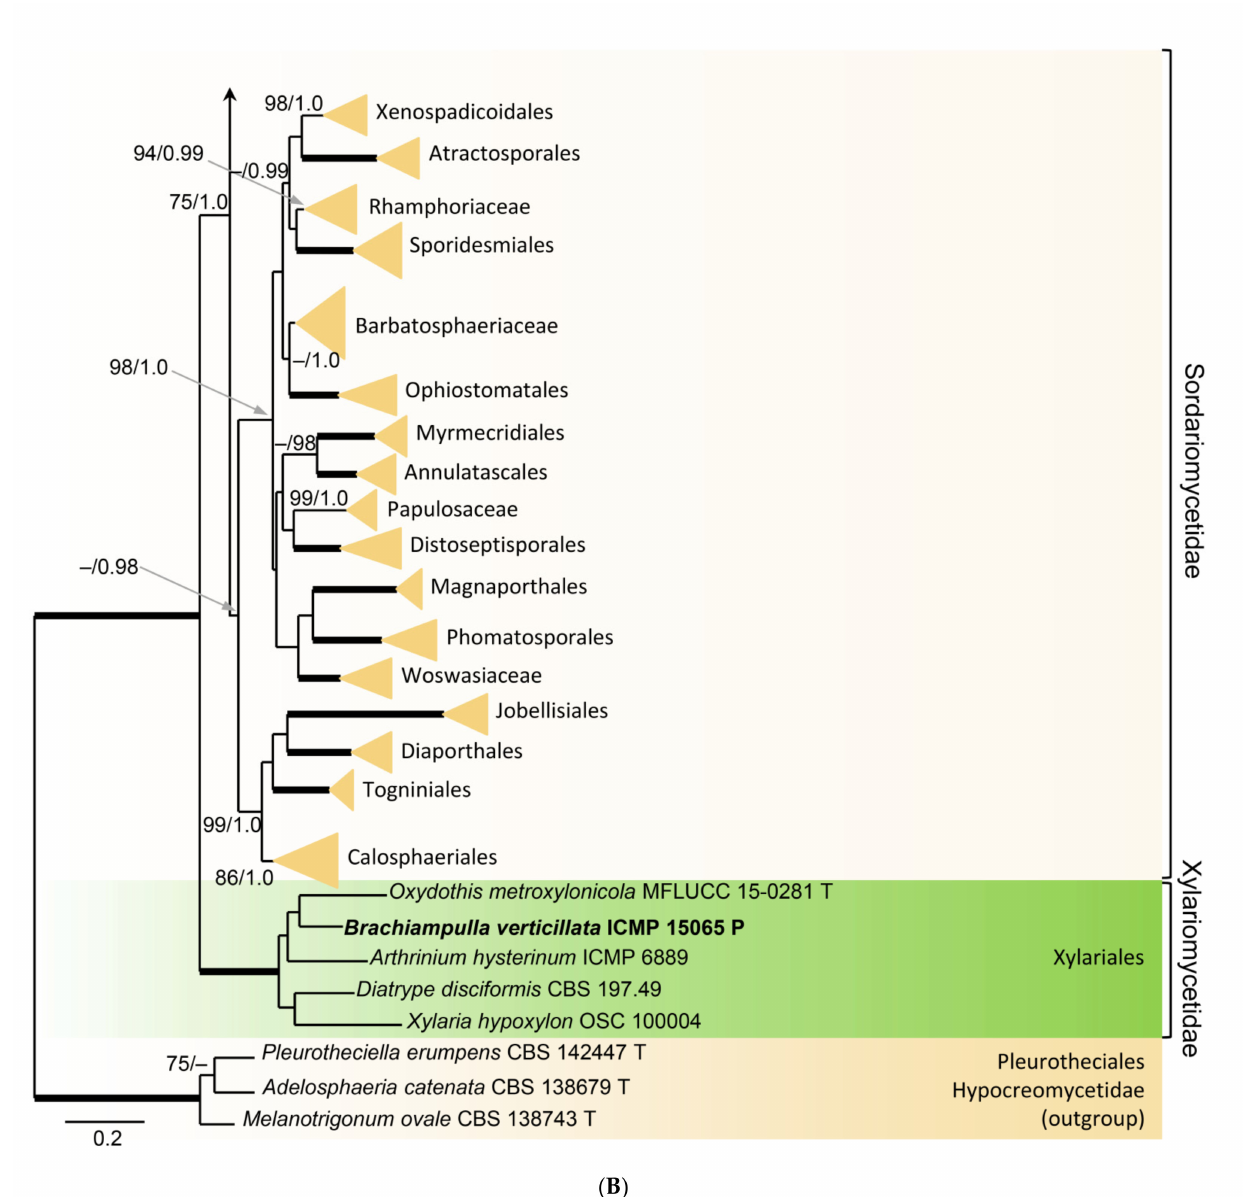
Figure 1. ( A ) Phylogenetic analysis of 18S, 28S and rpb2 of the Sordariomycetes. Species names given in bold are taxonomic novelties; T, E and P indicate ex-type, ex-epitype and ex-paratype strains. Taxa highlighted in green represent Selenosporella and selenosporella-like fungi in the Helminthosphaeriaceae. Thickened branches indicate branch support with maximum likelihood (ML) bootstrapping (BS) = 100%, posterior probabilities (PP) values = 1.0. Branch support of nodes ≥ 75% ML BS and ≥ 0.95 PP is indicated above or below branches. ( B ) Phylogenetic analysis of 18S, 28S and rpb2 of the Sordariomycetes (continued). For legend refer to ( A